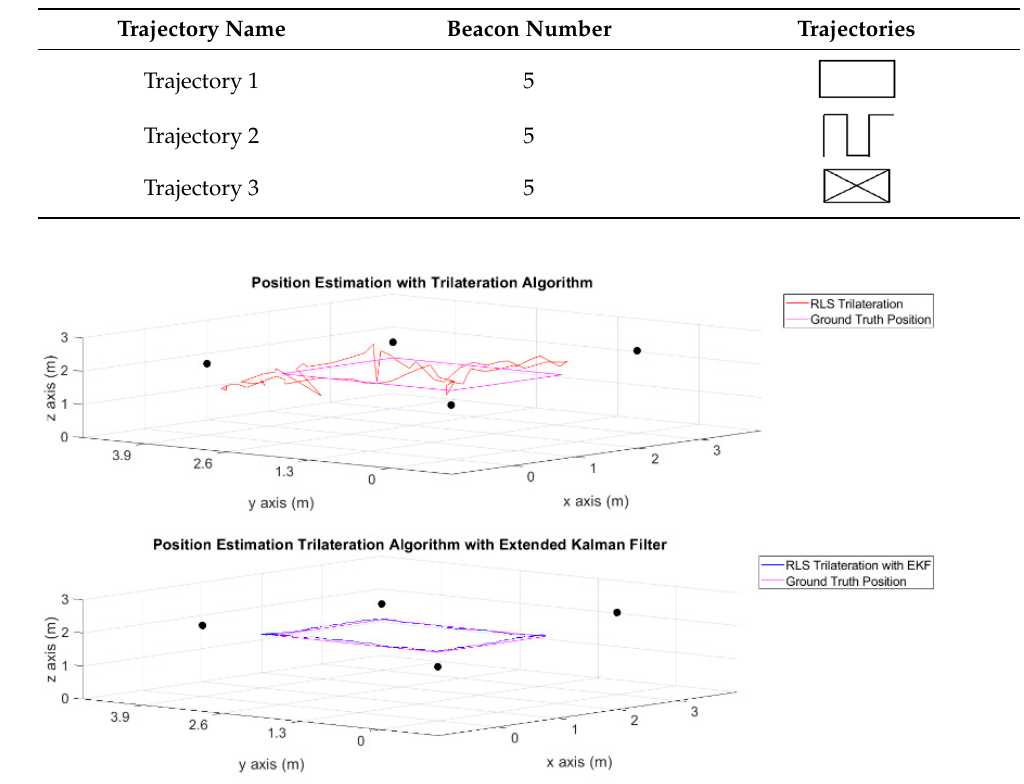
Figure 3. Position Estimation in Path 1 Trilateration Algorithm with and without EKF.